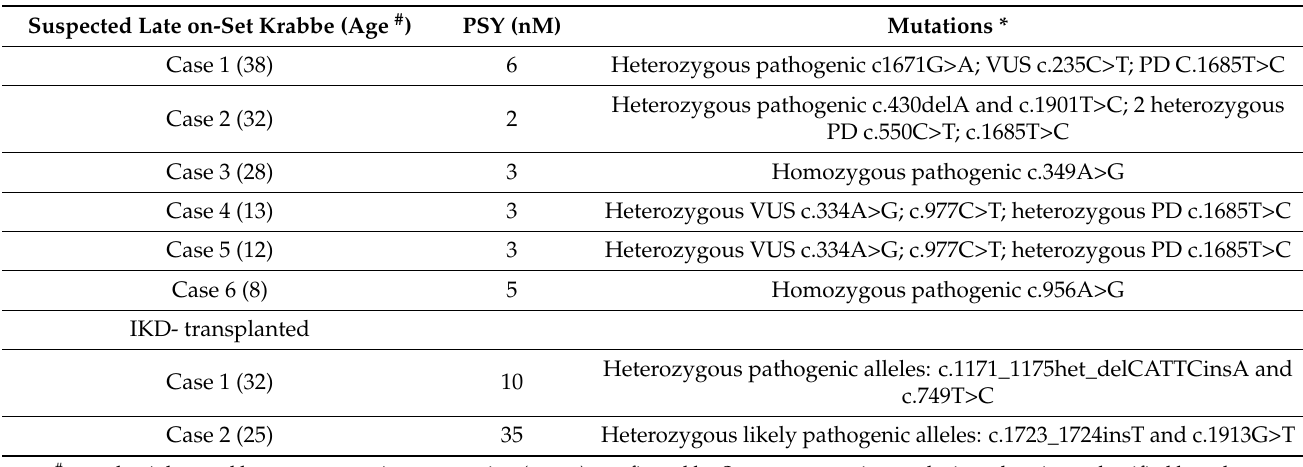
Table 3. PSY levels and mutations detected in late-onset suspected and IKD